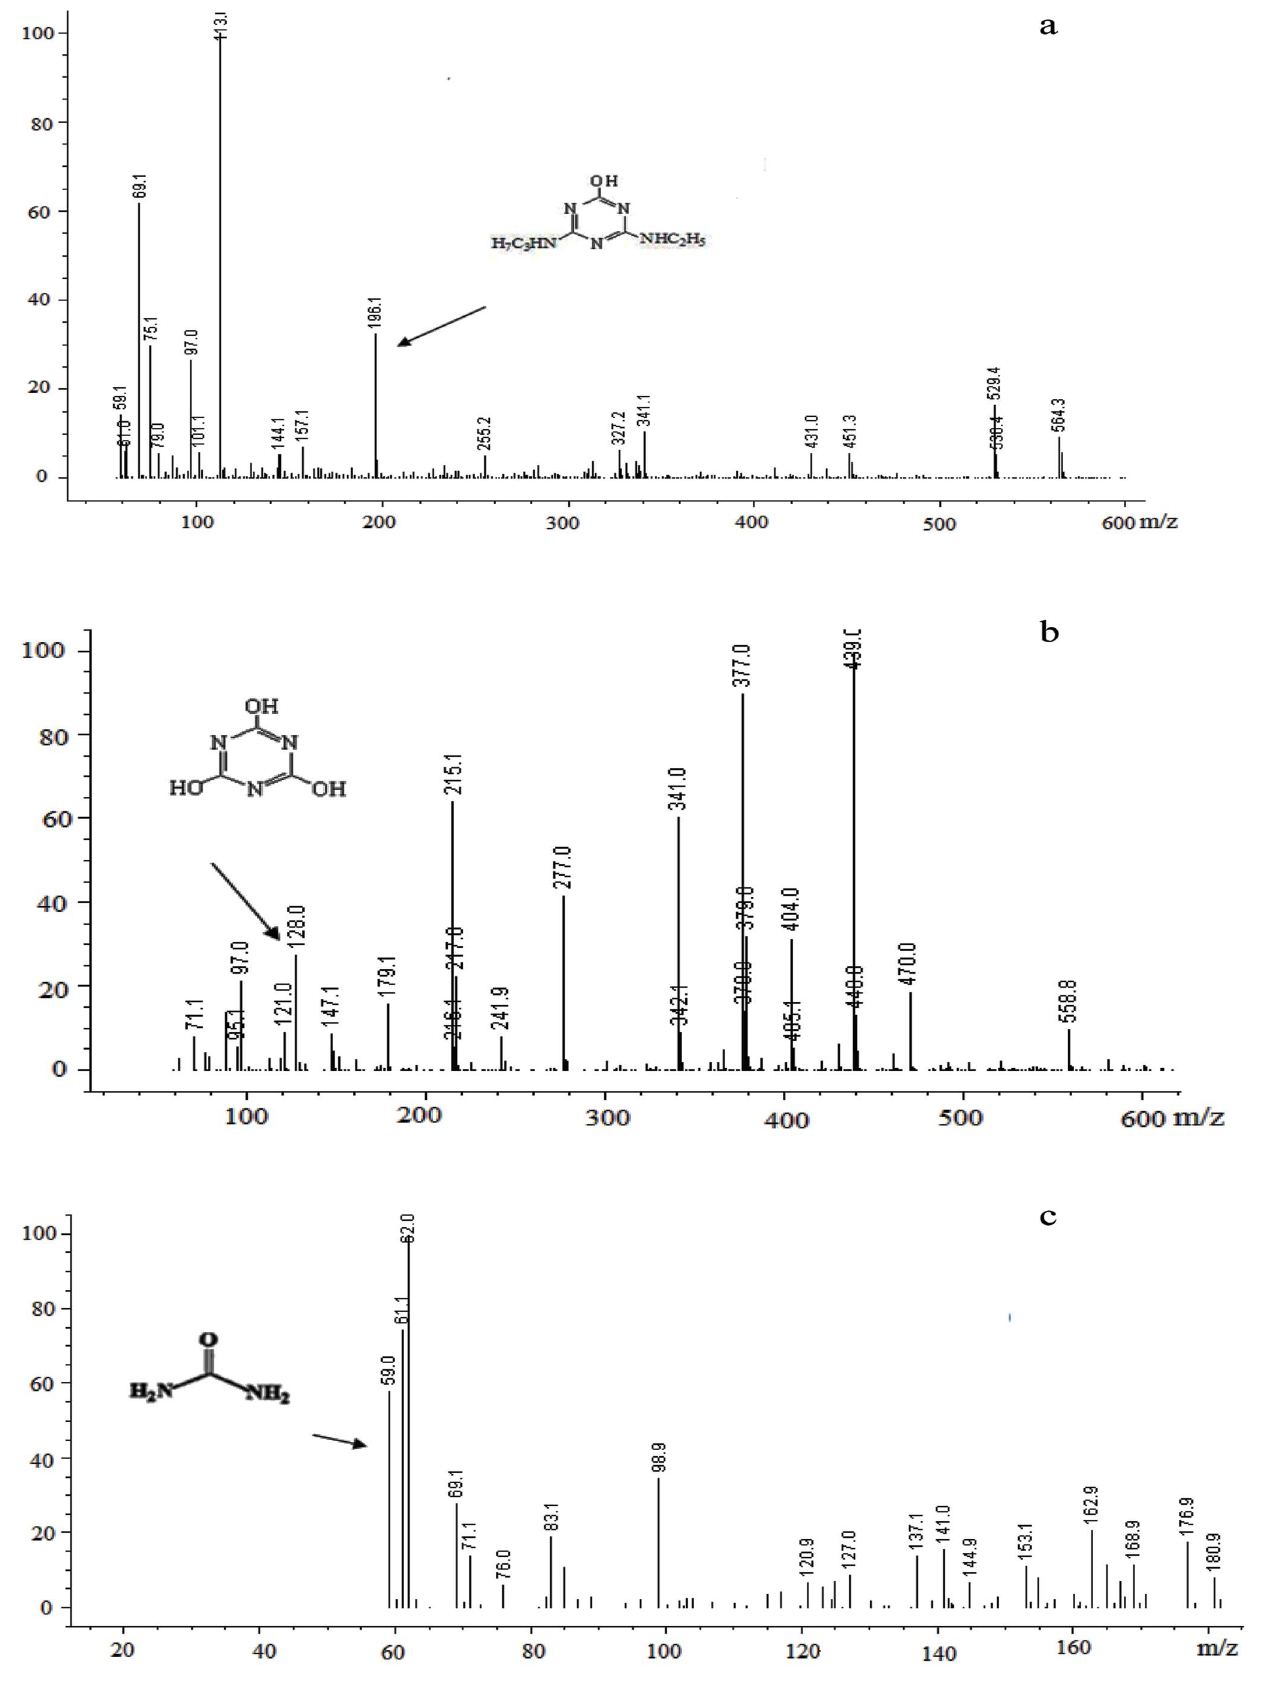
Figure 5. HPLC-MS identification of the metabolites produced from atrazine by HB-6. Hydroxyatrazine (a), cyanuric acid (b) and urea (c). doi:10.1371/journal.pone.0107270.g005 PLOS ONE |